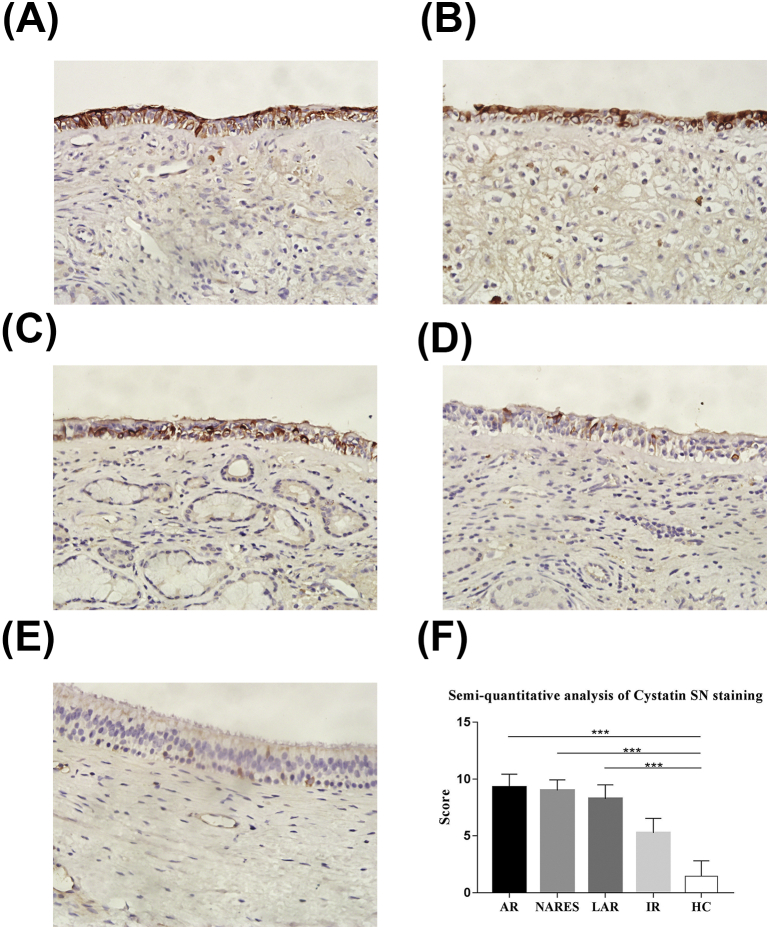
Localization of Cystatin SN between different groups. In the AR (A), NARES (B), LAR (C), IR (D), and control (E) groups (H&E, 400 × magnification). (F) Semiquantitative analysis of stained Cystatin SN in the control subjects and patients with AR, NARES, LAR, and IR (for each group, n = 5). The data are presented as mean ± standard deviation (SD). ∗∗∗: p < 0.001. AR, allergic rhinitis; NARES, nonallergic rhinitis with eosinophilia syndrome; LAR, local allergic rhinitis; IR, idiopathic rhinitis